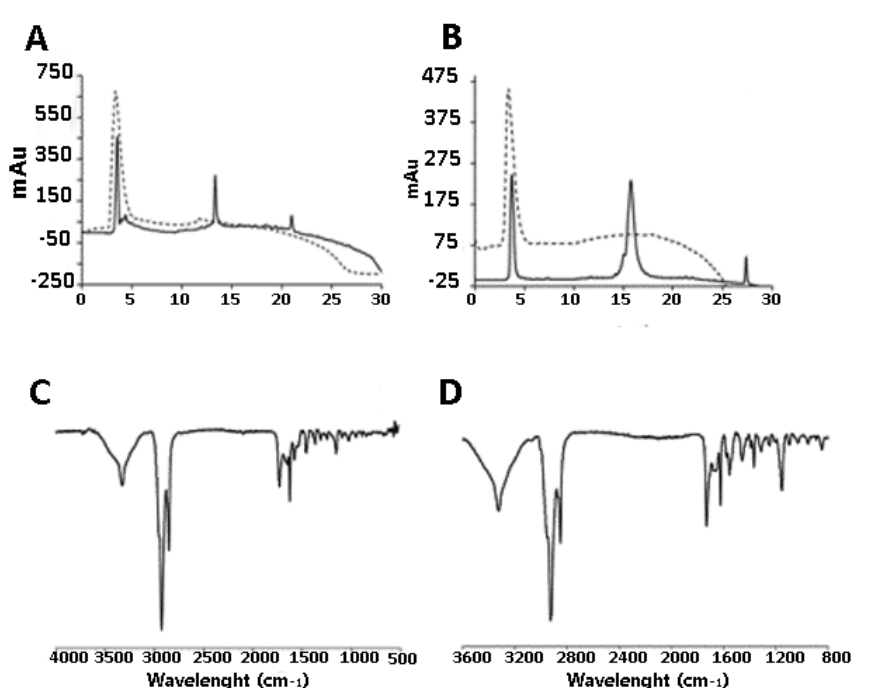
Figure 2. HPLC traces of crude (solid line) and purified (dashed line) peptidodendrimer conjugates, DendrimerA-gH (panel A ), DendrimerA-gB (panel B ). IR spectroscopic analysis of DendrimerA-gH (panel C ) and DendrimerA-gB (panel D ).